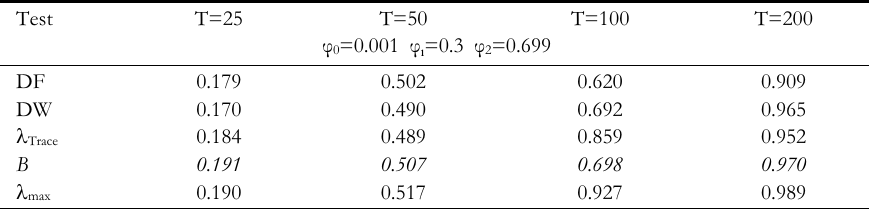
Estimation of the power of the tests, nominal level